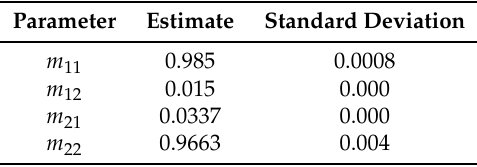
Table 3. Markov transition matrix: probabilities to switch from a low volatility state to a high volatility state and vice versa.